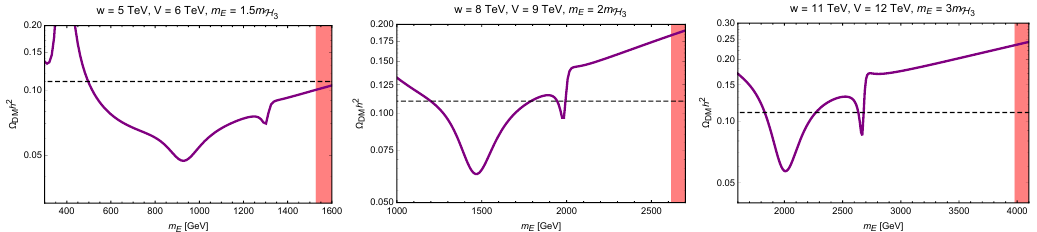
Figure 15 . The total relic density of fermion and scalar dark matter as the function of the fermion dark matter mass corresponding to the m E ; m